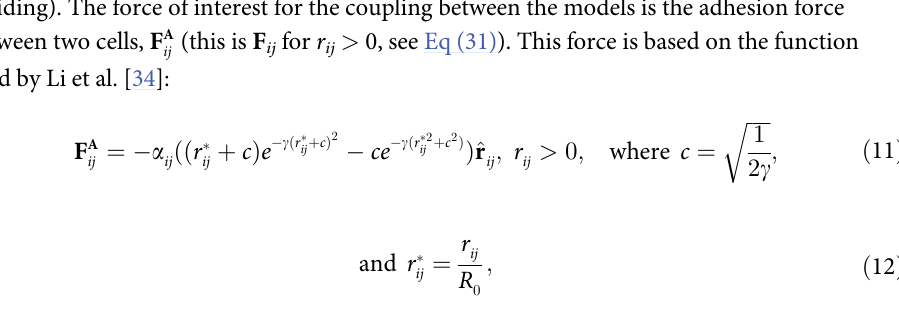
= i = 0.1 nM. This is a reduction in T T